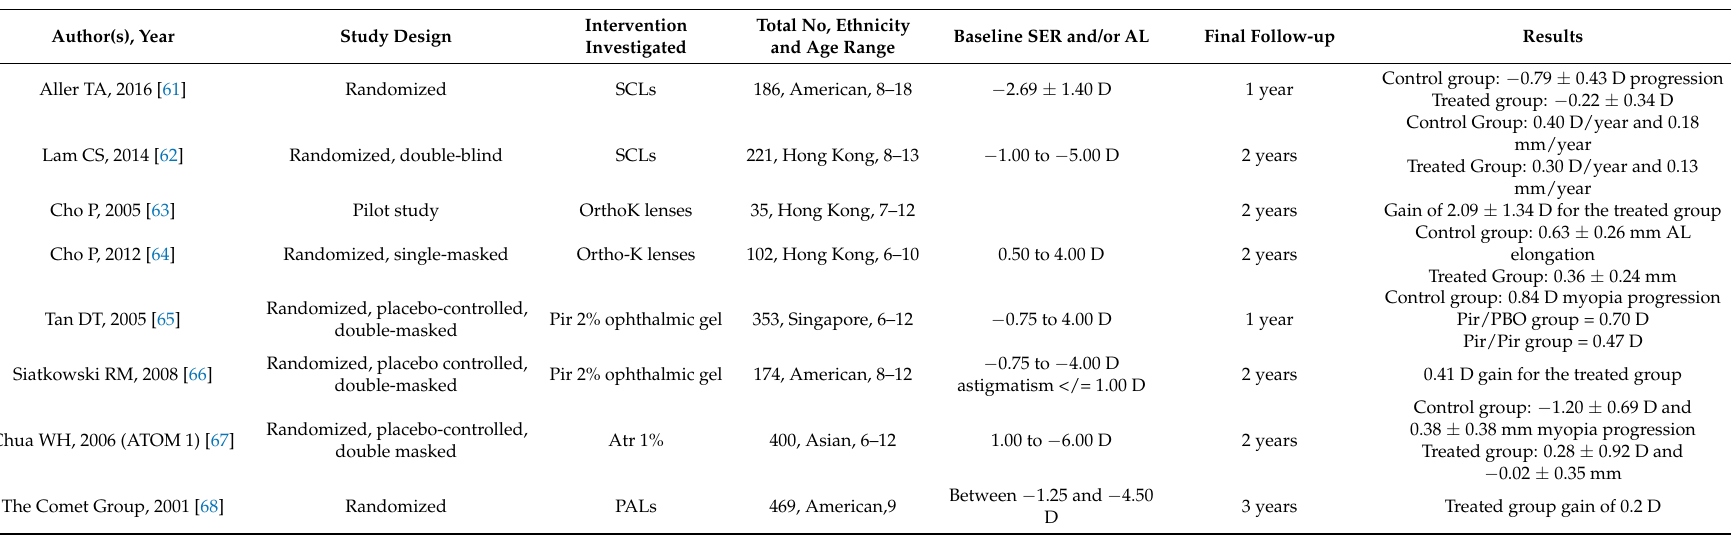
Table 1. Randomized clinical trials investigating the clinical efficacy of each interventions in slowing myopia